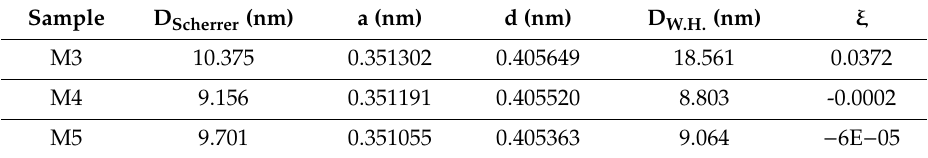
Table 3. Structural parameters calculated using XRD patterns of the selected titania samples.